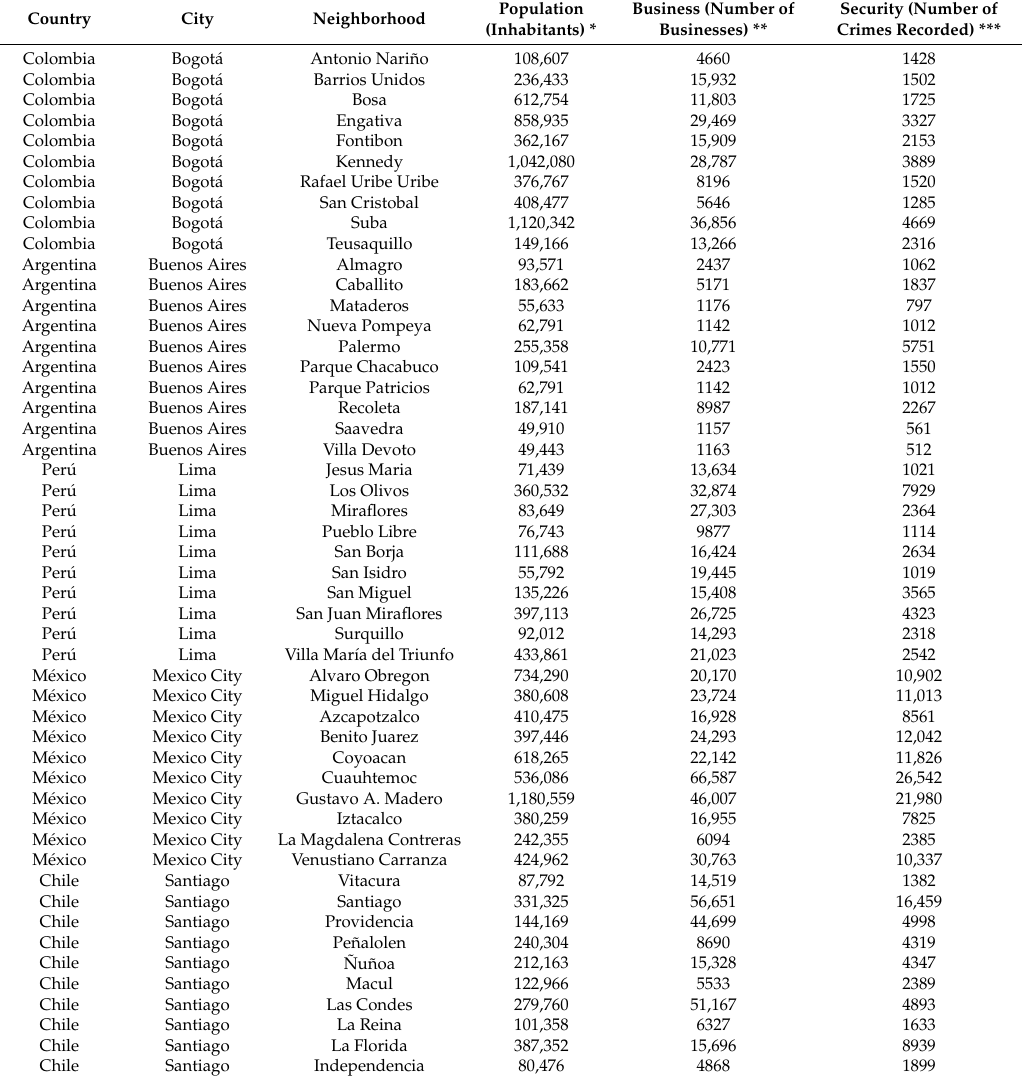
Table A2. Independent social variables used in the study (2013). All data were divided between the area of each